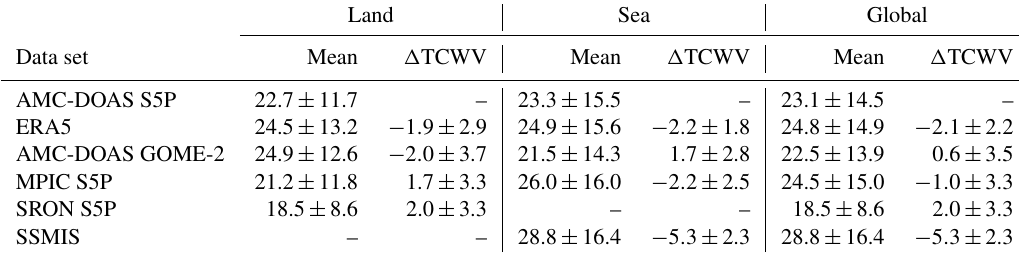
Table 4. Same as Table 3 but for July